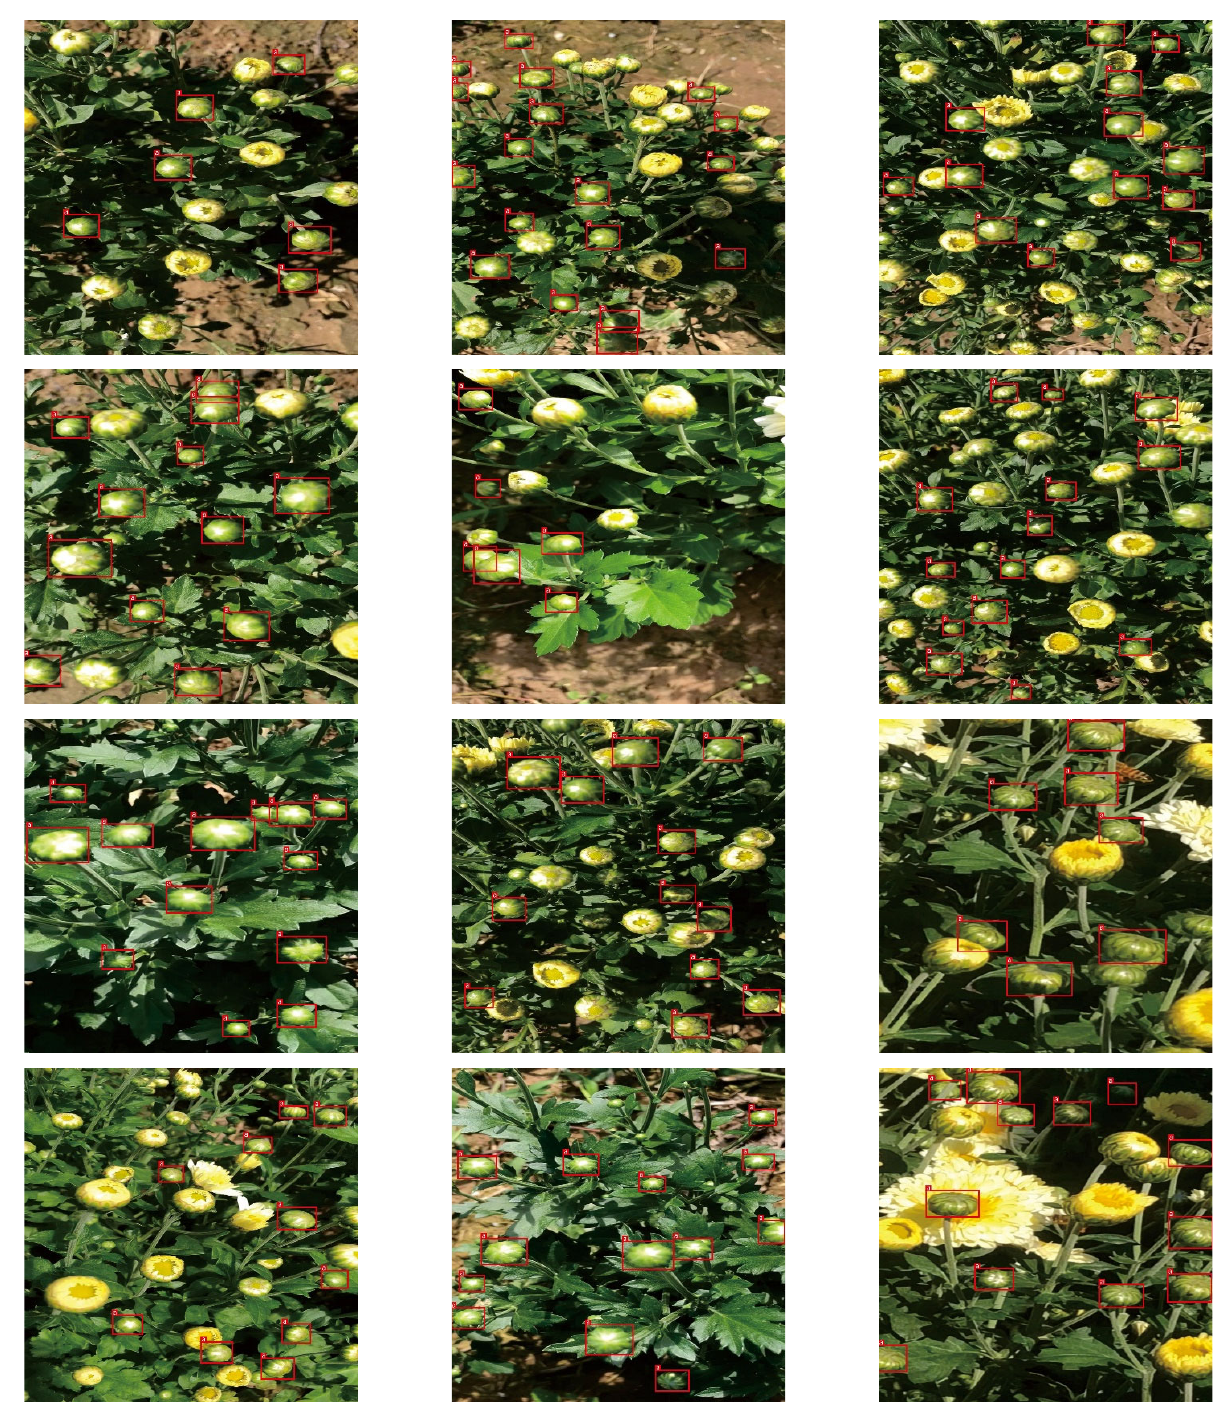
Figure 7. The test results on the NVIDIA Jetson TX2.